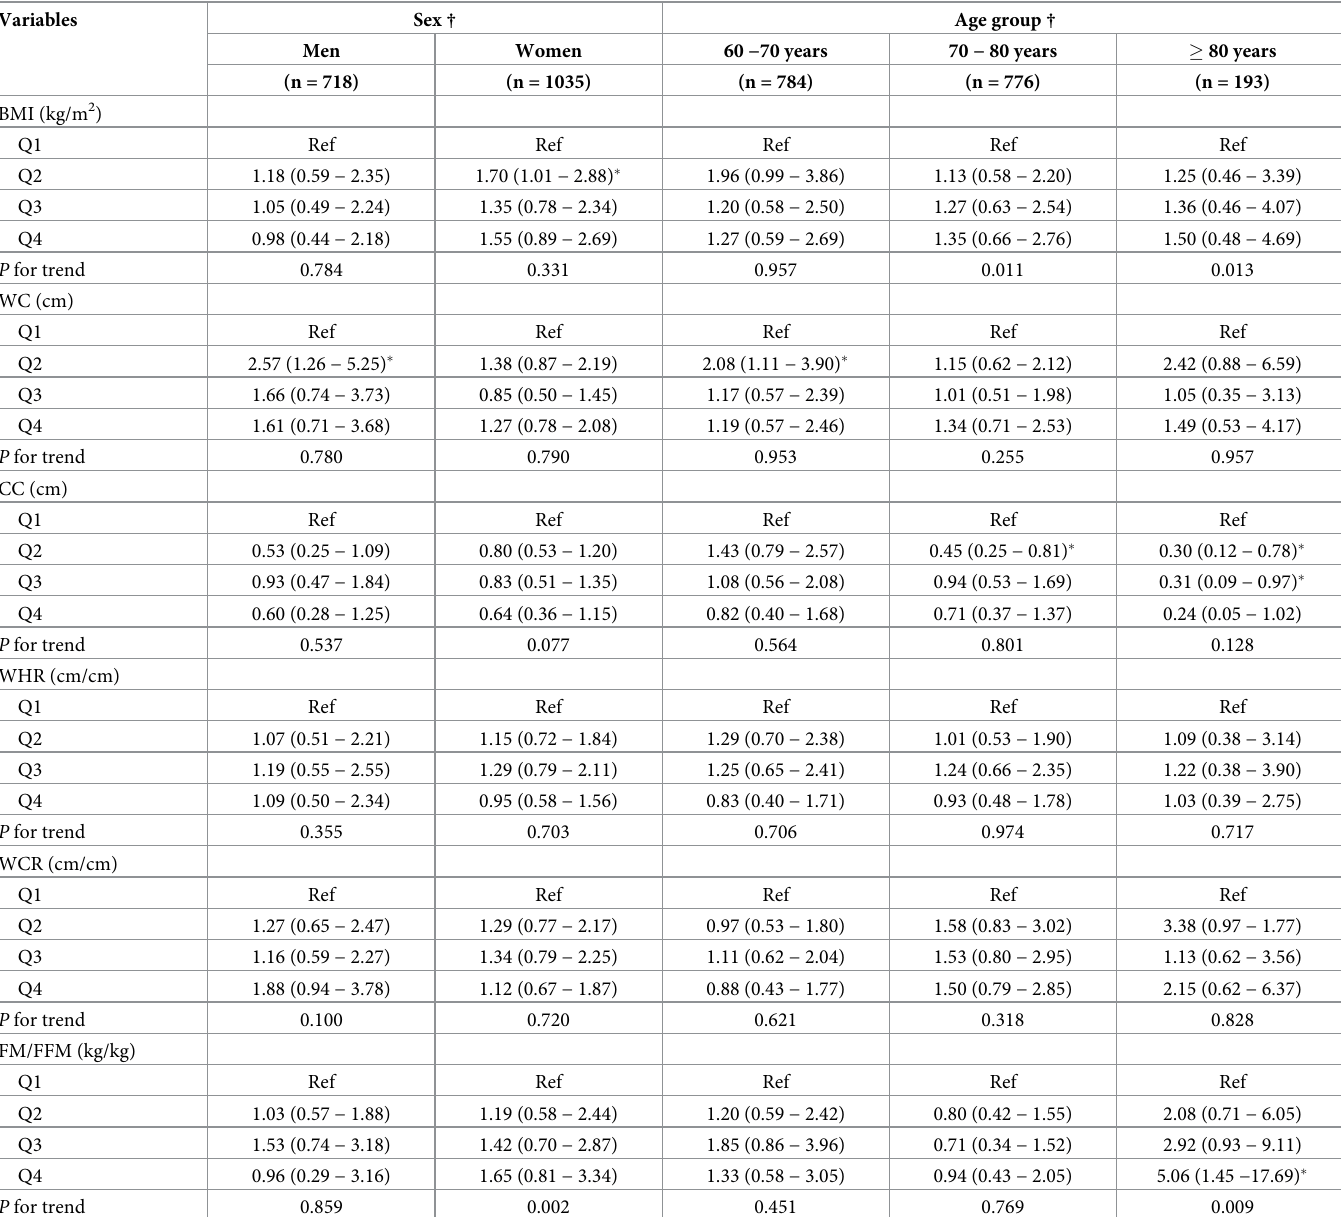
Table 4. Logistic regression analyses of the association of BMI, WC, CC, WHR, WCR and FM/FFM quartiles with cognitive impairment, by sex and age group.